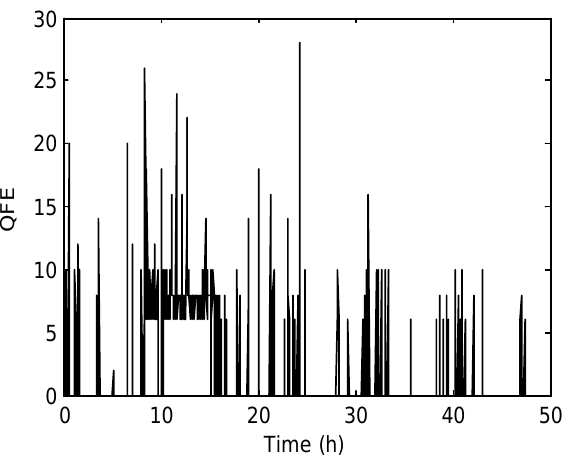
Figure 4. Function evaluation in the base case of fault 7.